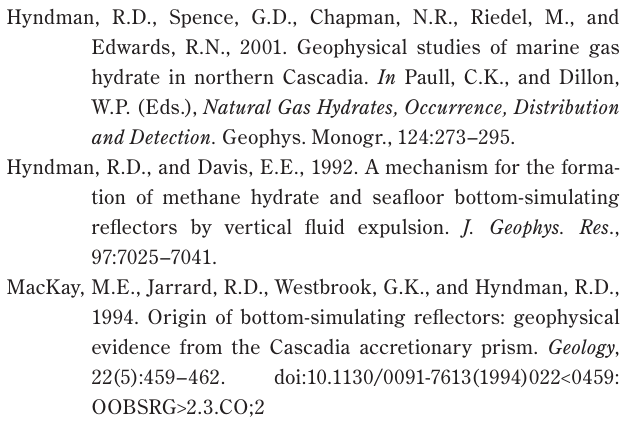
Fig. 1: map from D. Kelly and J. Delaney, University